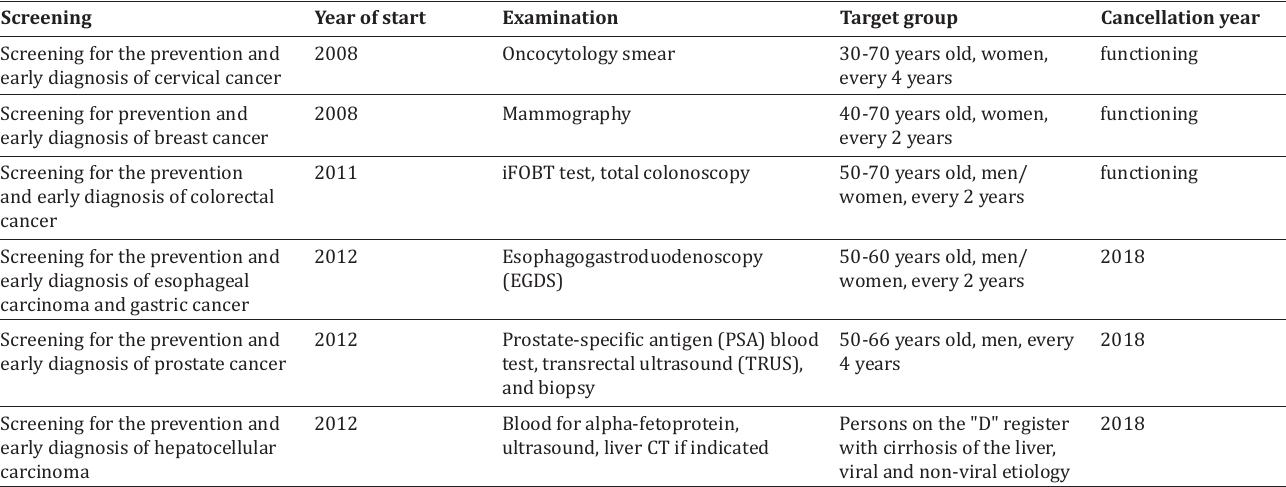
Development of screening programs in Kazakhstan Screening Year of start